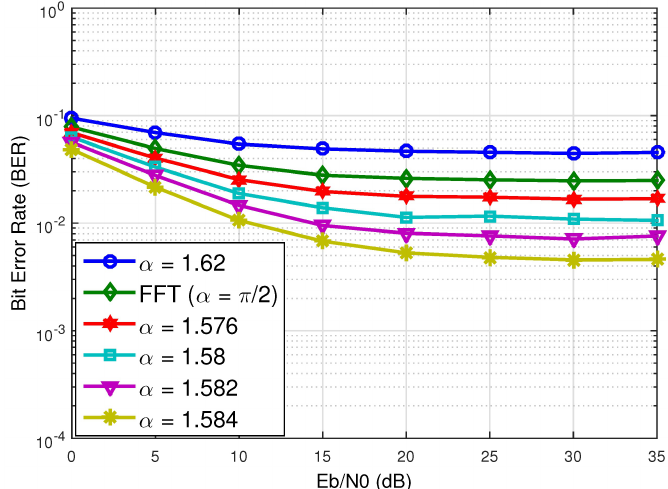
Fig. 2 FRFT and FT reduction PAPR comparison diagram based on SLM algorithm. FT, Fourier transform; FRFT, fractional Fourier transform; SLM, selective